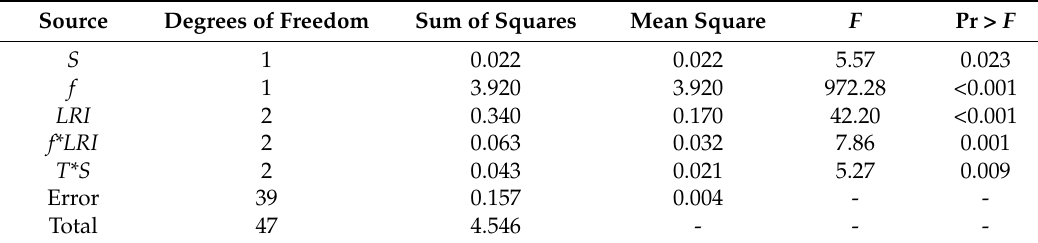
Table 6. ANOVA results for Ra Naperian logarithm.